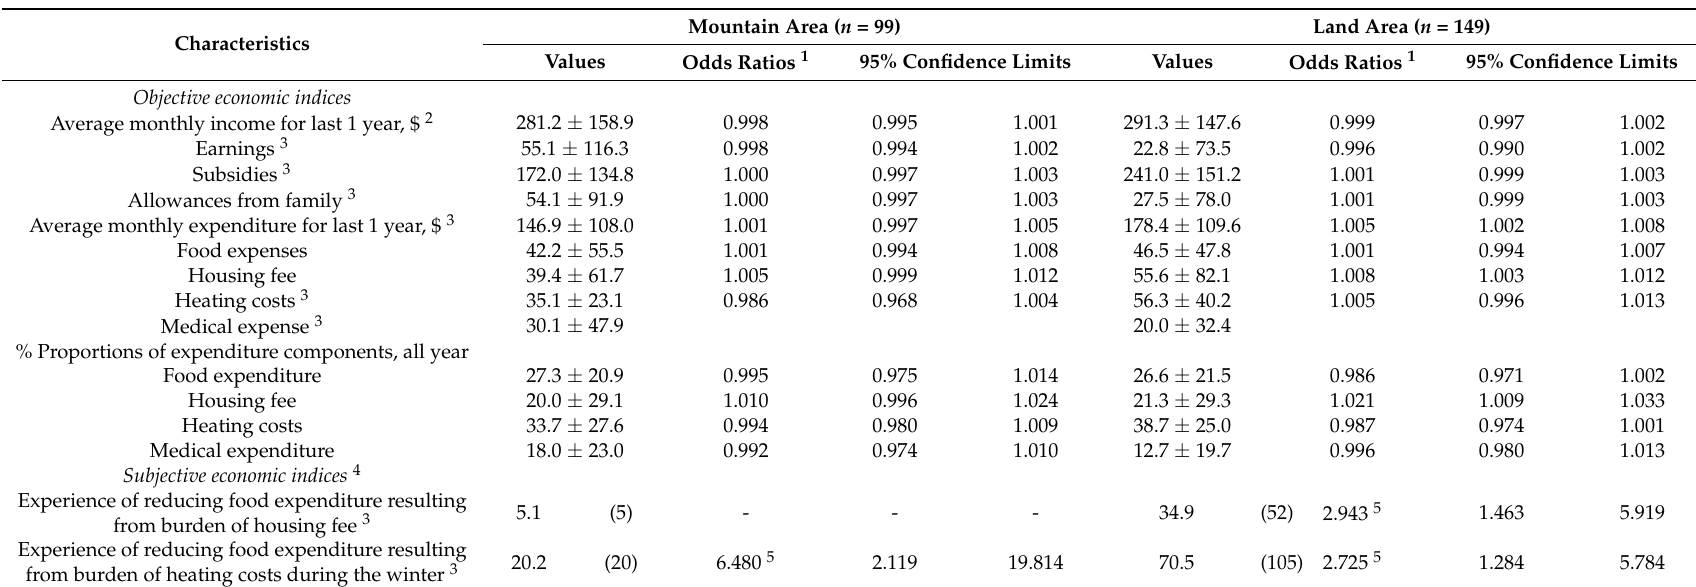
Table 2. Economic characteristics of households and risks for food insecurities according to different rural